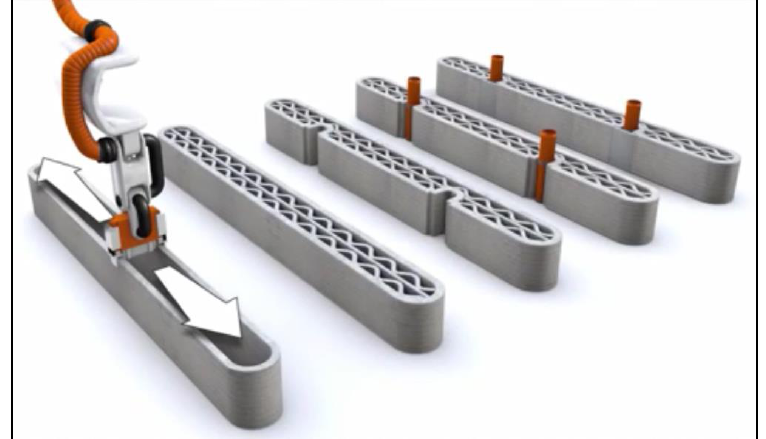
Figure 3. Schema of built walls by CC and placing the passages for the needed installations [2].